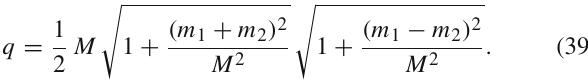
Fig. 2 ( N = 2 , 3 , 4)-body phase space functions (Eq. 43), scaled by the appropriate powers of pion mass, versus the center of mass